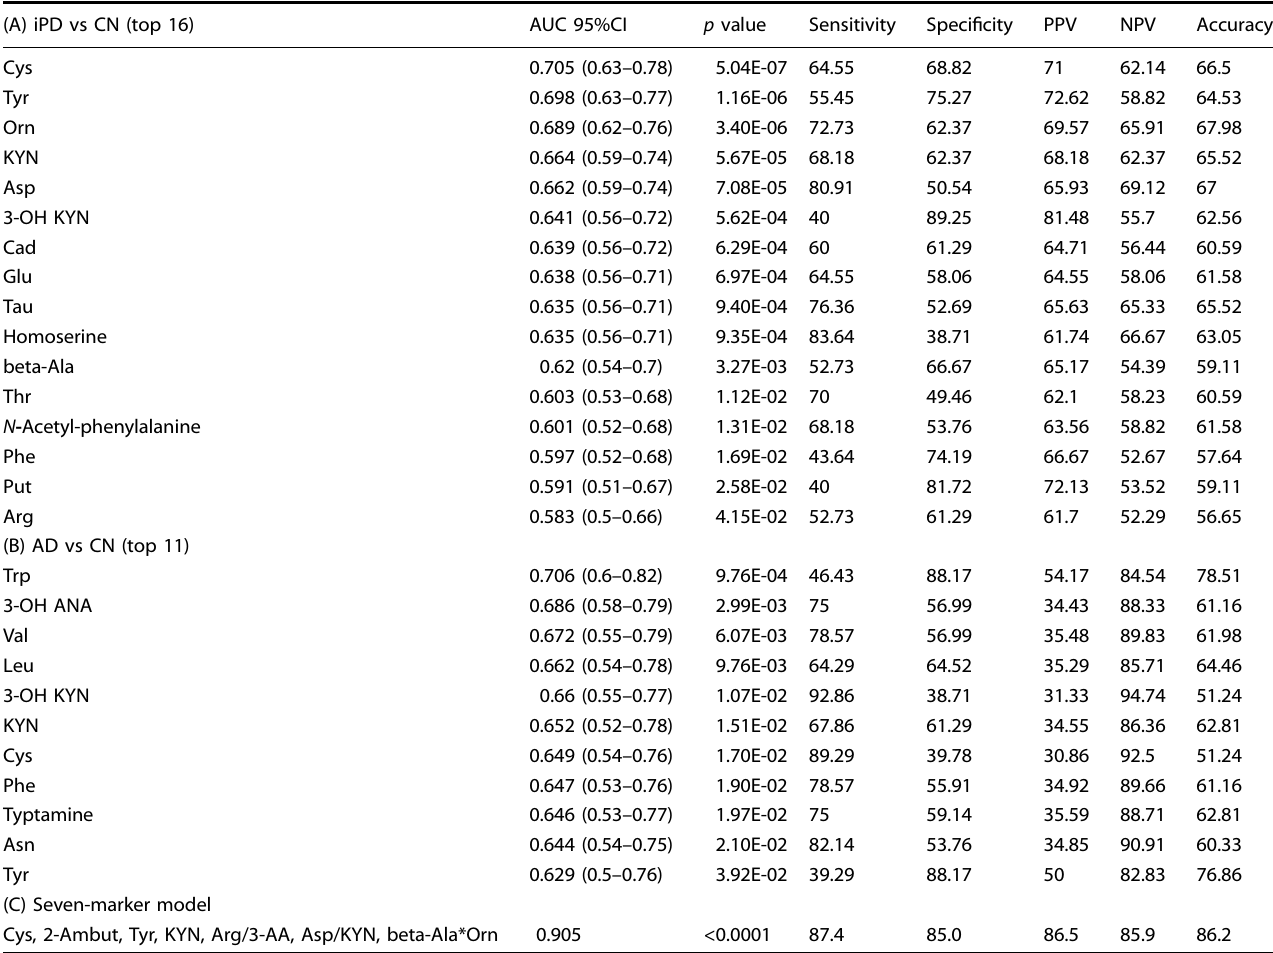
Table 2. ROC curve analysis for biomarker performance evaluation and diagnostic test results, including ROC curve with a 95% con fi dence interval, p value, sensitivity, speci fi city, positive predicted value (PPV), negative predicted value (NPV) and accuracy